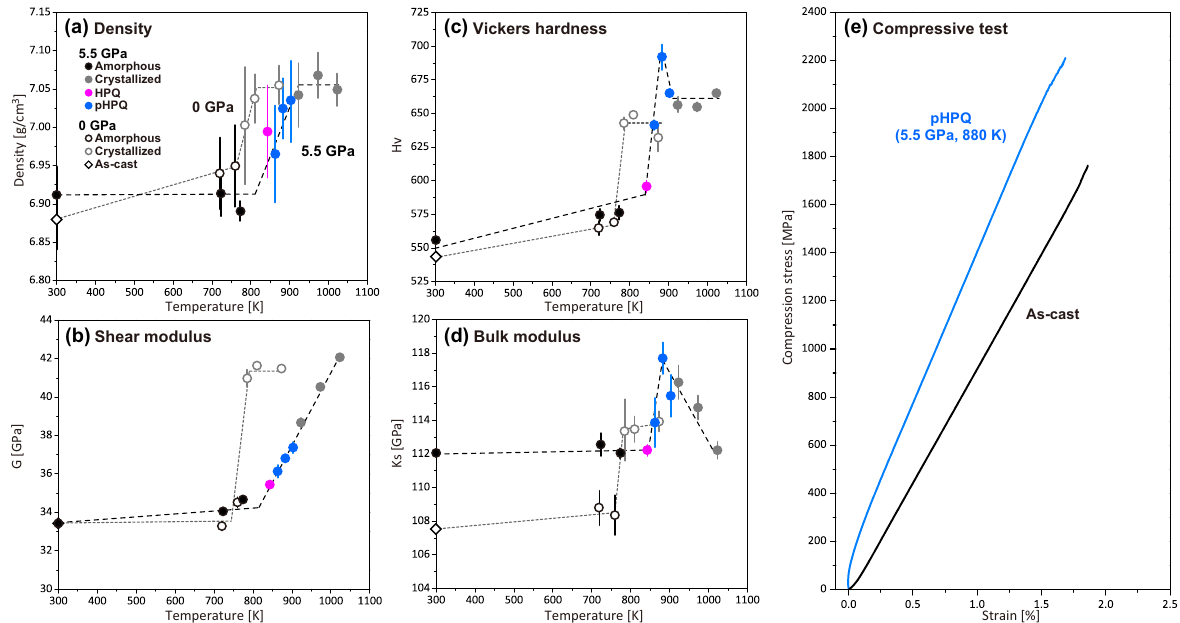
Fig. 8 Effect of high-pressure annealing on mechanical properties of the Zr 50 Cu 40 Al 10 BMG. a Density, b shear modulus, c Vickers hardness, and d bulk modulus as a function of synthesized temperature. Results of the ambient-pressure annealing are shown for comparison. Solid and open symbols denote the data at a synthesis pressure of 5.5 GPa and ambient pressure, respectively. Black and gray symbols denote the amorphous and crystallized samples, respectively. Purple and blue symbols denote the data of the HPQ and pHPQ samples, respectively. Open diamond denotes the data of the as-cast sample. Dashed and dotted lines are to guide the eyes. Errors are determined as two sigma of the standard deviation. The error bars fall within symbols if those do not appear. e Stress – strain curves of the as-cast (black) and pHPQ (blue) samples. The nonlinear behavior of the stress – strain curve of the pHPQ sample ~0% strain is probably due to the barreled shape of the sample after the high-pressure experiment. The compressive strength and Young ’ s modulus of the pHPQ sample synthesized at 880 K and 5.5 GPa are 2210 MPa and 126 GPa, respectively, while those of the as-cast sample are 1760 MPa and 95 GPa,